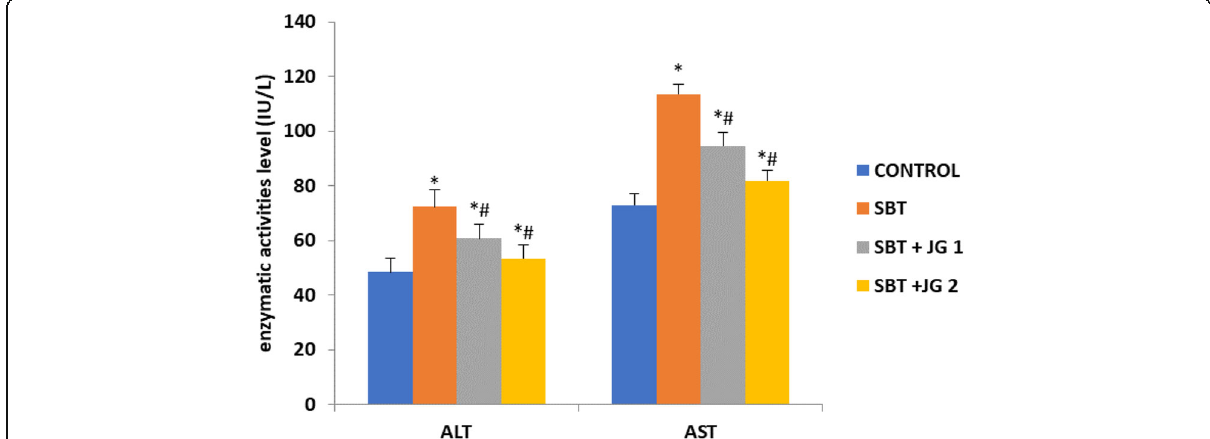
Fig. 3 The effect of methanolic leaf extract of Jatropha tanjorensis on sodium benzoate mediated alteration in serum ALT and AST in experimental rats. Data presented as Mean ± standard deviation ( n = 6). *Significantly different from normal control group at P < 0.05, # significantly different from group SBT at P < 0.05. Control: Animals were given distilled water only; SBT: Animals were treated with oral administration of sodium benzoate (200 mg/kg bw) only; SBT + JG1: Animals were given sodium benzoate (200 mg/kg bw) + J. tanjorensis extract (200 mg/kg b.w); and SBT + JG2: Animals were given sodium benzoate (200 mg/kg bw) + J. tanjorensis extract (500 mg/kg b.w)